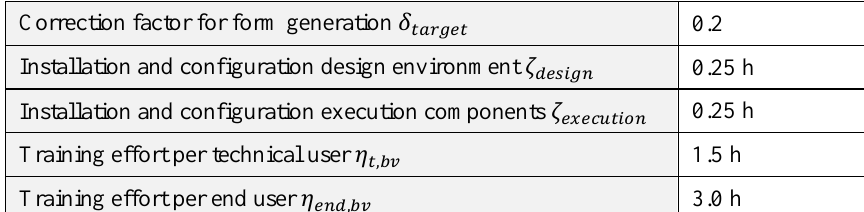
Table 8. Cost drivers and normalized